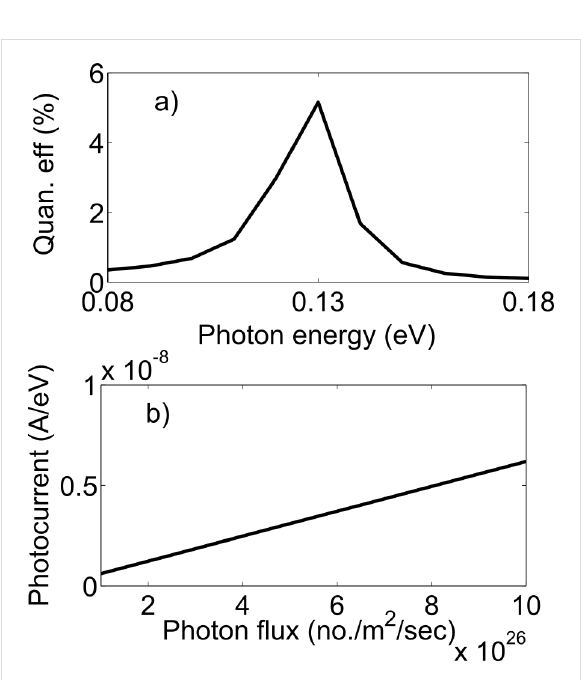
Figure 9: (a) The variation of the external quantum efficiency with photon energy. (b) Linear trend of peak photocurrent with photon flux (zigzag device).